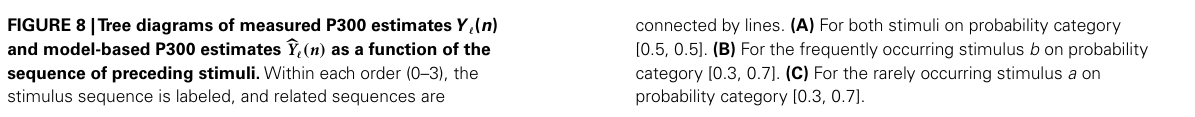
connected by lines. (A) For both stimuli on probability category [0.5, 0.5]. (B) For the frequently occurring stimulus b on probability category [0.3, 0.7]. (C) For the rarely occurring stimulus a on probability category [0.3,